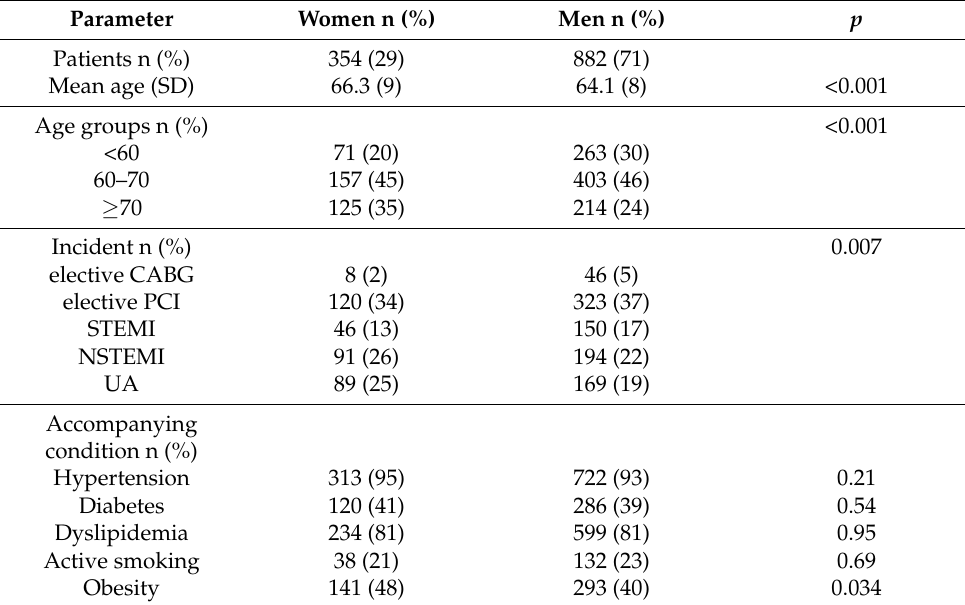
Table 1. Clinical characteristics of the groups of women and men.